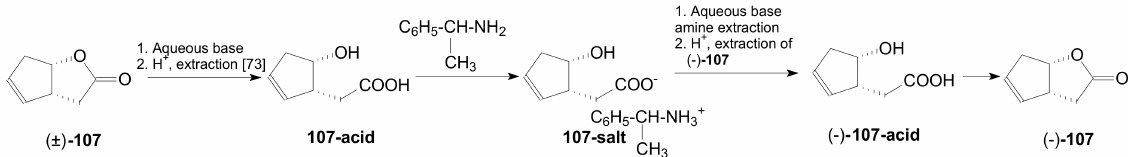
Scheme 22. Separation of the enantiomerically pure lactone ( − )-107 from the racemic 107 by the salt of hydroxy-acid with (+)- α